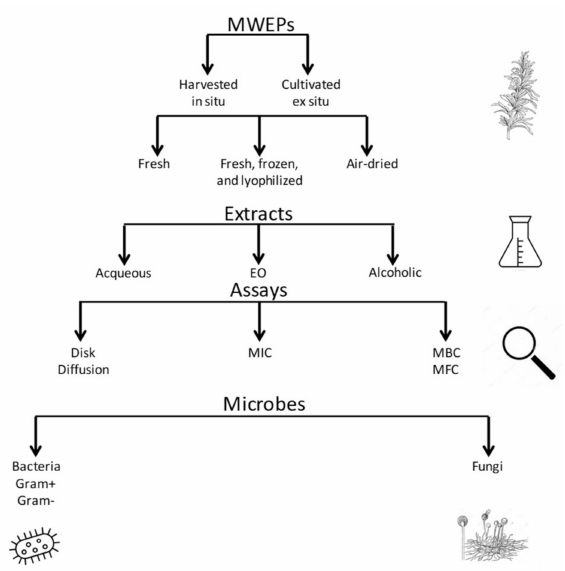
Figure 2. Graphical picture of the different types of plant materials, solvents for extracts, assays for antimicrobial properties, and pathogenic microbes (bacteria and fungi) tested.